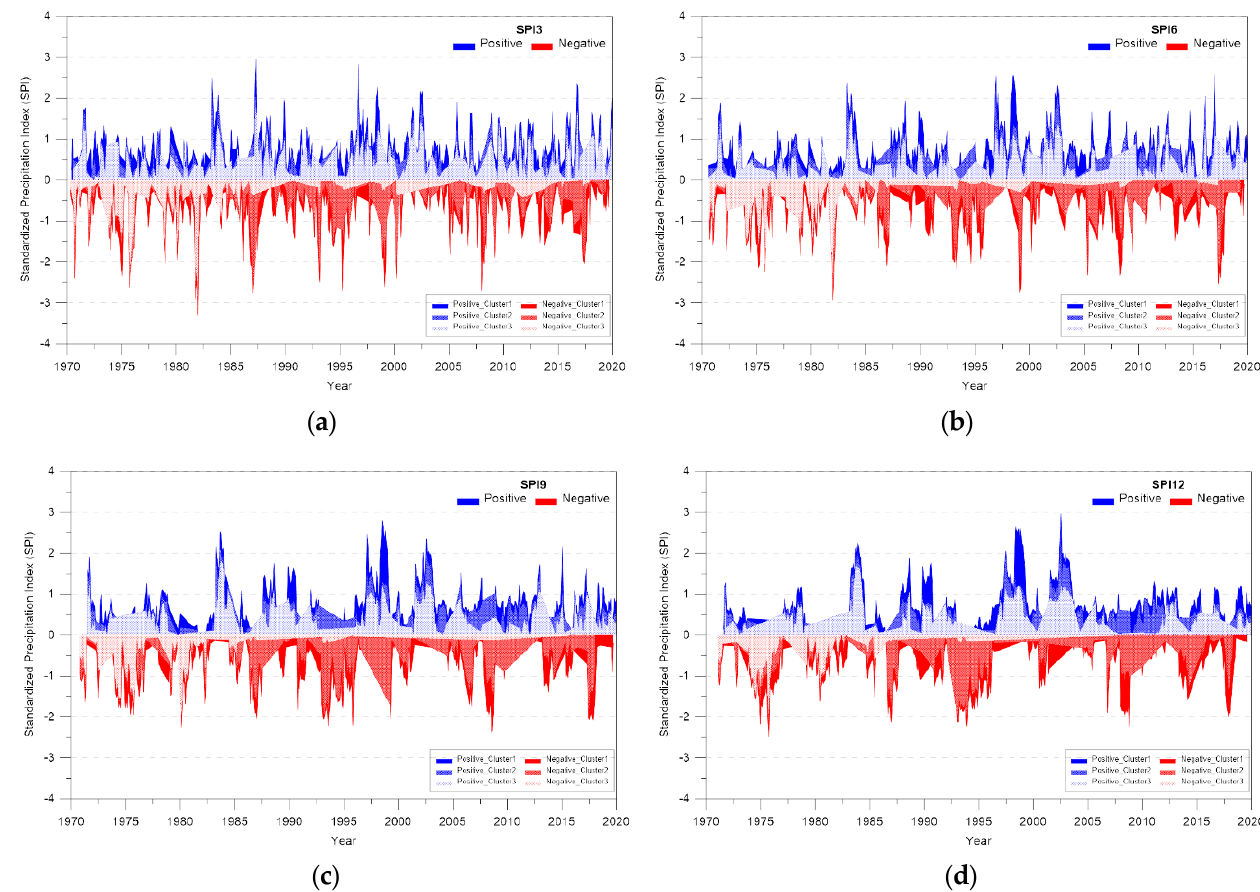
Figure 9. SPI of Gyeongsangnamdo by duration based on cluster analysis: ( a ) SPI3; ( b ) SPI6; ( c ) SPI9; ( d ) SPI12.